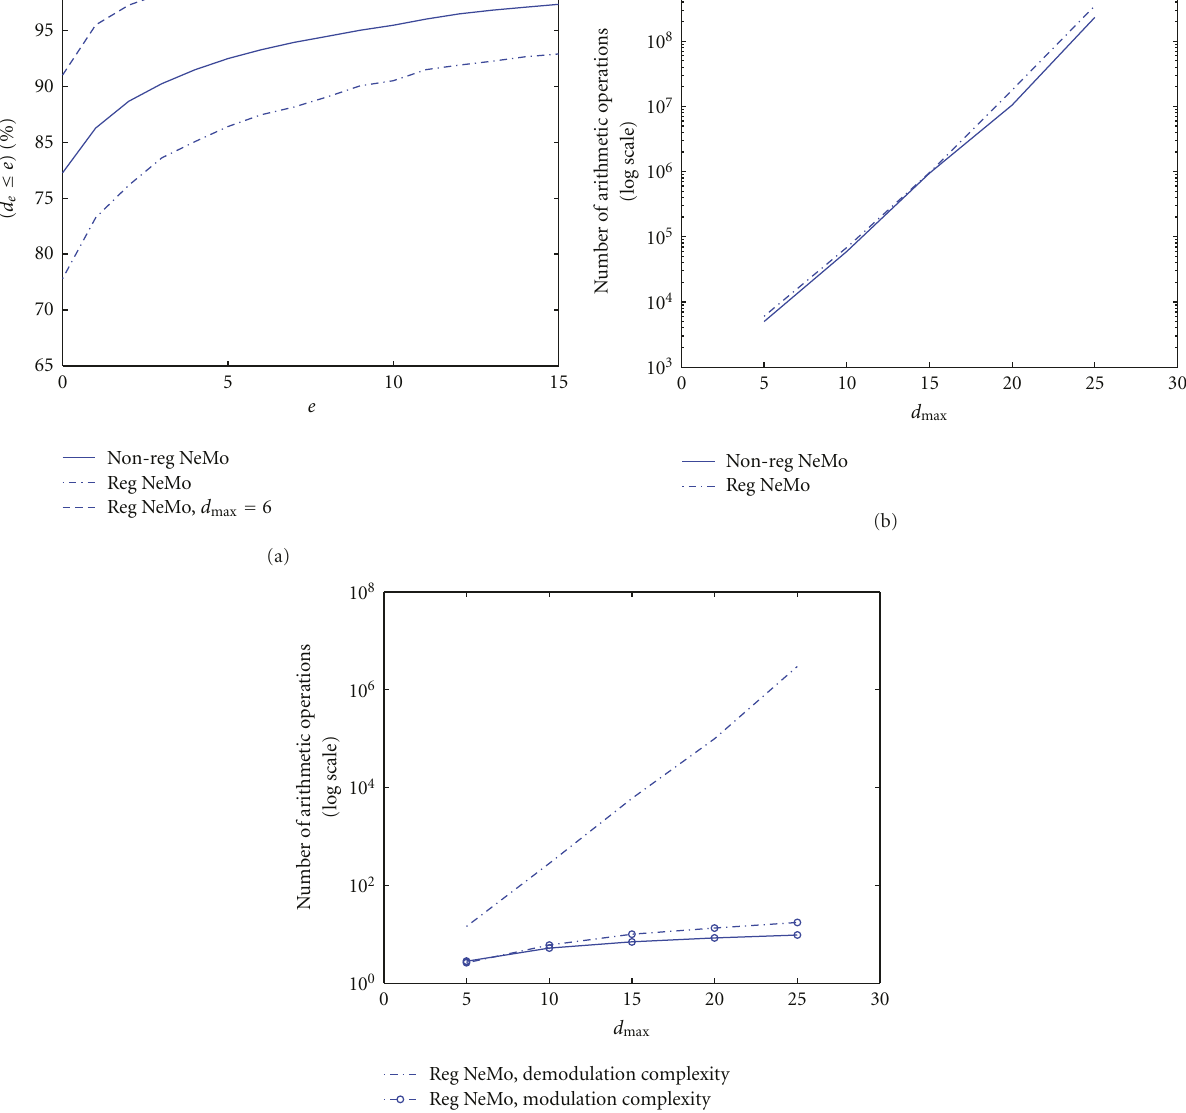
the persistence 1, the nonregenerative NeMo actually has the less total